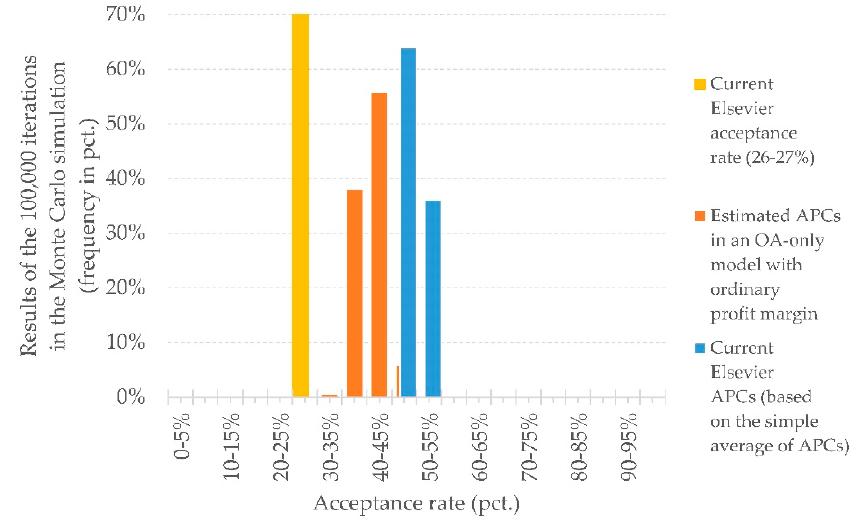
Figure 4. Results: potential acceptance rates with current Elsevier APCs in comparison to acceptance rates with estimated average APCs in an OA-only model and an ordinary profit margin (based on 2018 data).